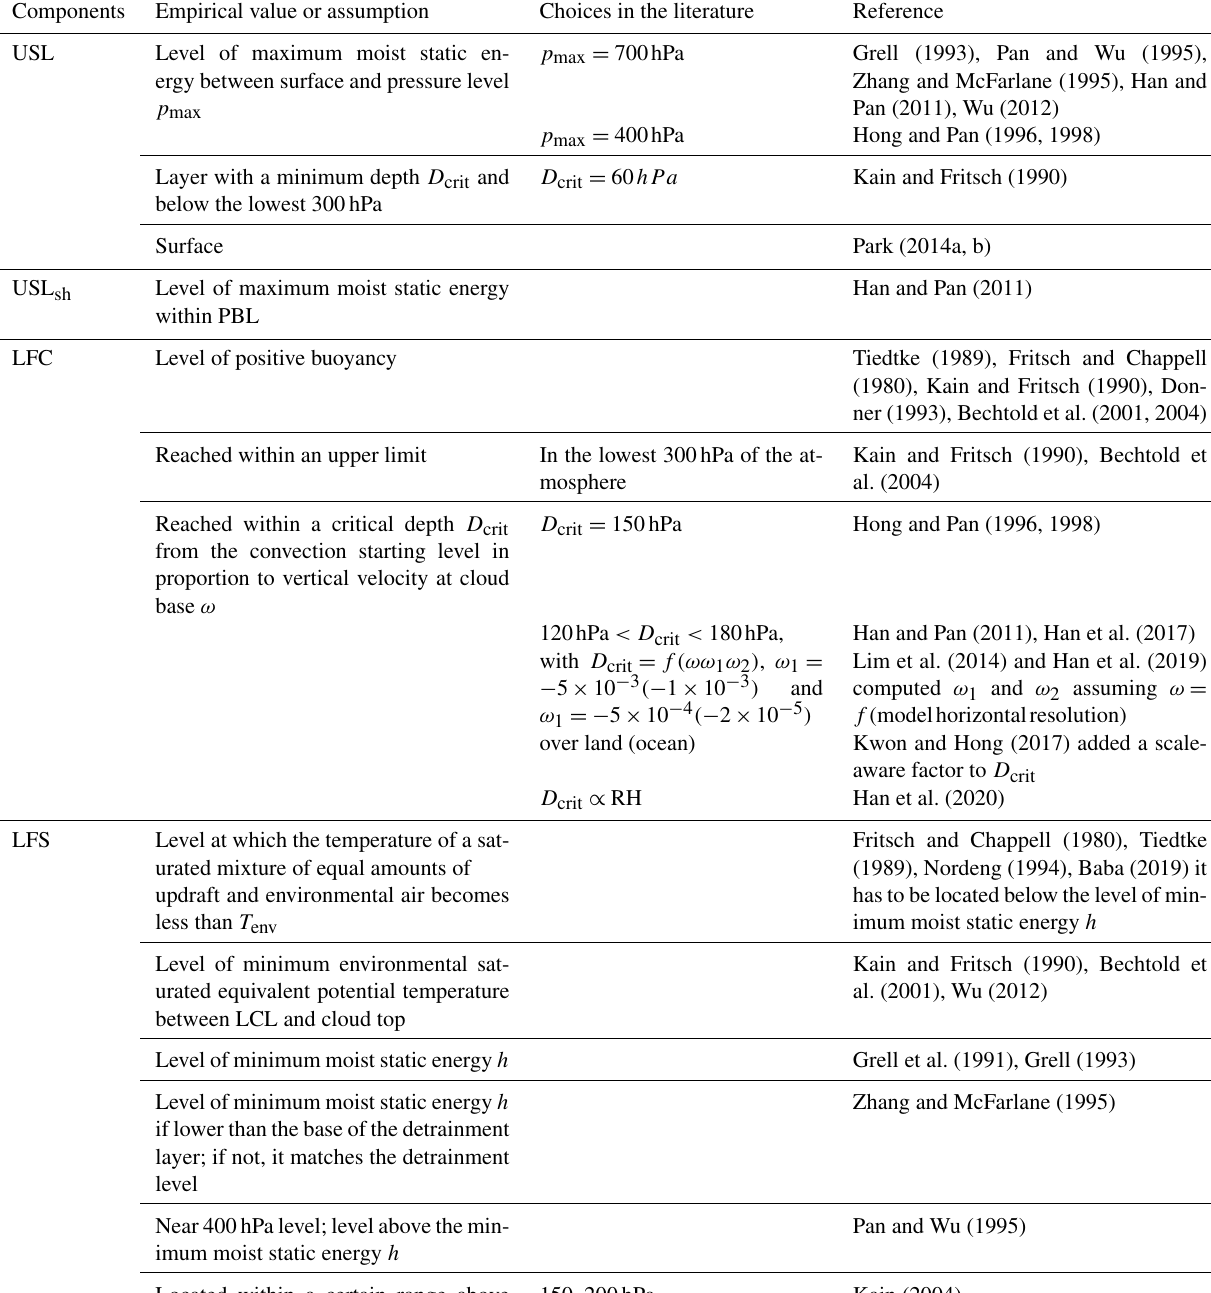
Table 4. A sample of empirical values and assumptions used in the starting levels (note: subscript “sh” refers to shallow convection).